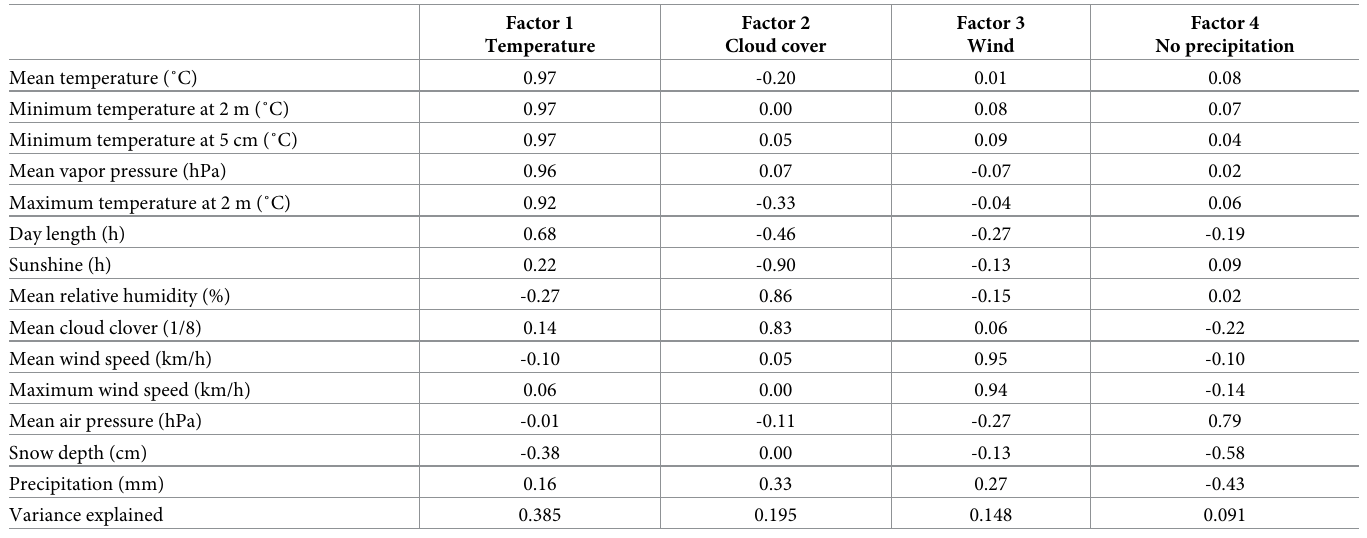
Table 1. Factor loadings of meteorological variables and explained variance of factors derived by principal component analysis (n =